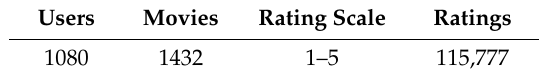
Table 8. Applied dataset for evaluating the quality of movie